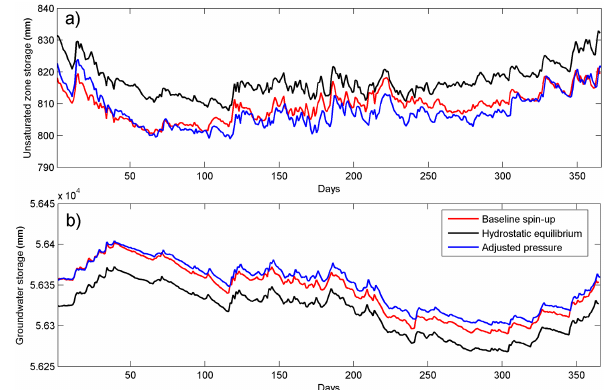
Figure 5. Comparison of (a) unsaturated and (b) groundwater stor- ages of the ParFlow.CLM equilibrium year using the hybrid and baseline spin-up approaches (Ajami et al., 2014). The equilibrium year corresponds to simulation cycles of 10, 12 and 20 for the ad- justed pressure head, hydrostatic equilibrium, and baseline simula- tions, respectively. The dynamics of groundwater and unsaturated zone storages are closely reproduced by the adjusted pressure head distribution approach relative to the baseline spin-up approach for the Skjern River